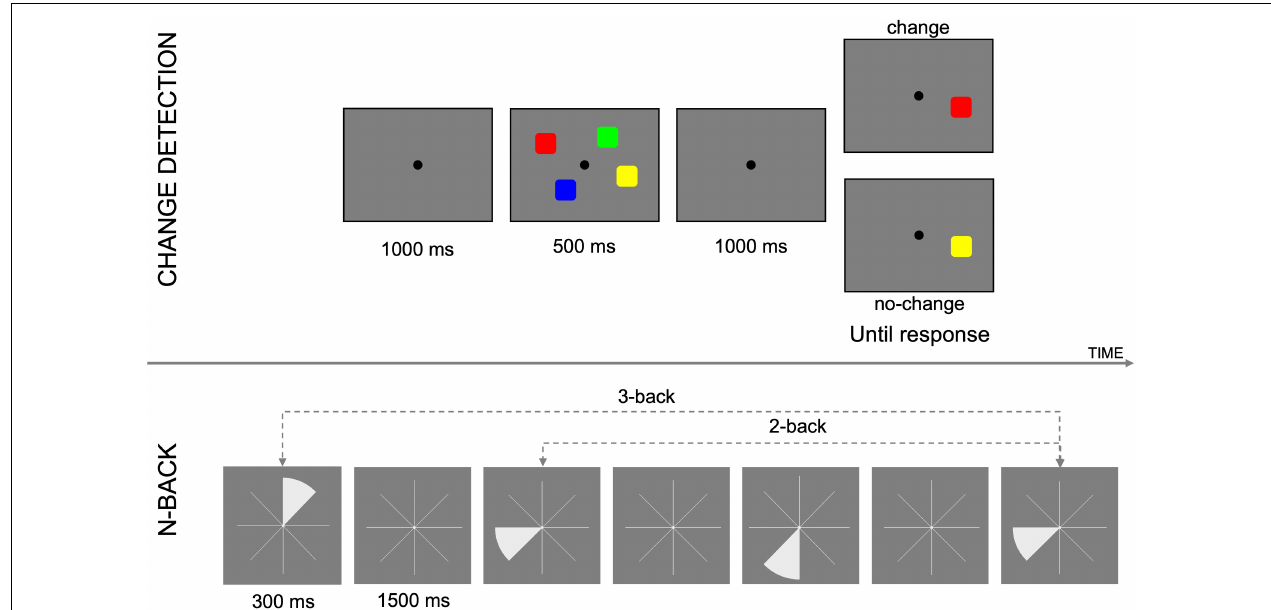
FIGURE 2 | Exemplification of tasks and stimuli used in this study. Above, change detection task; below, n-back